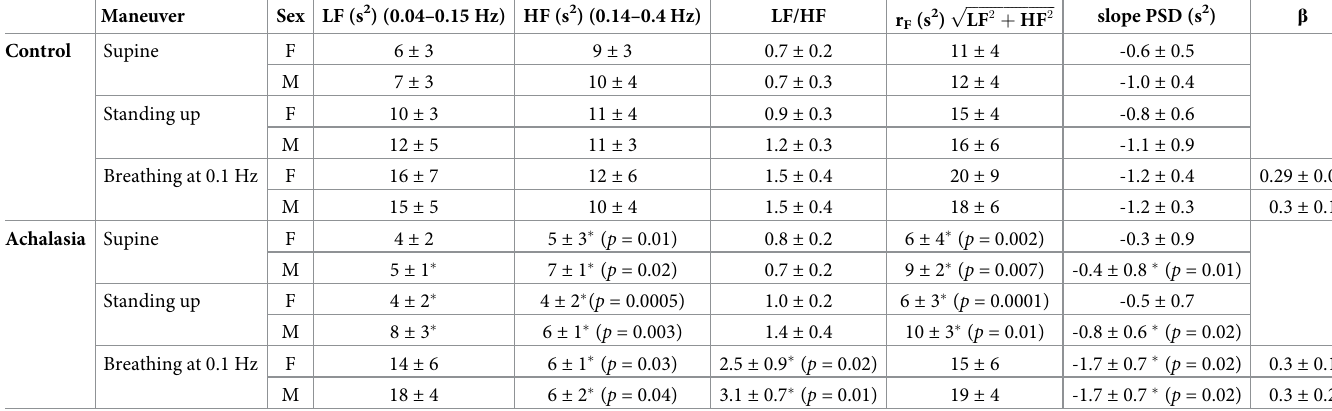
Table 3. Interbeat interval in the frequency domain.